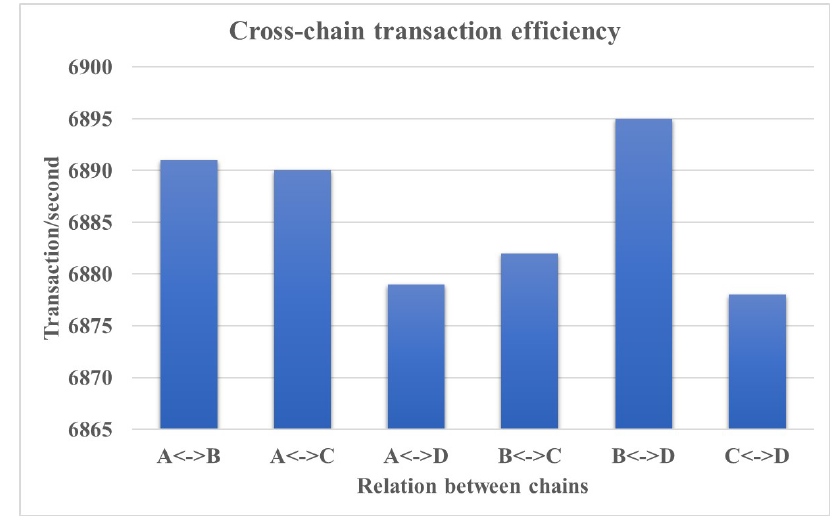
Figure 12. Cross-chain transaction